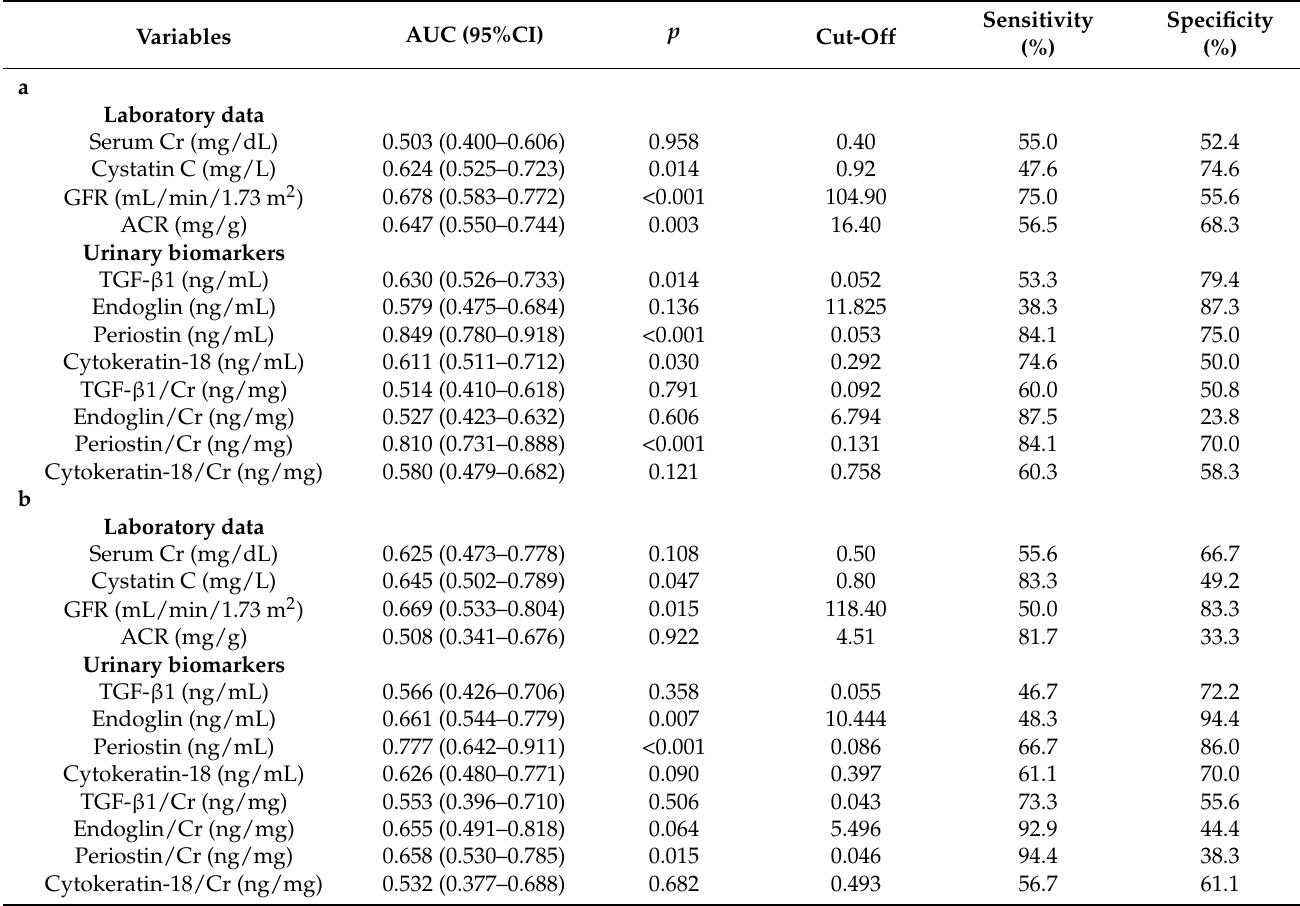
Table 7. Diagnostic usefulness of laboratory variables for diagnosing severe, moderate renal scars and borderline lesions. a . Diagnostic usefulness of laboratory variables for diagnosing severe and moderate renal scars in the scintigraphy ( n = 63). b . Diagnostic usefulness of laboratory variables for diagnosing renal borderline lesions in the scintigraphy ( n =